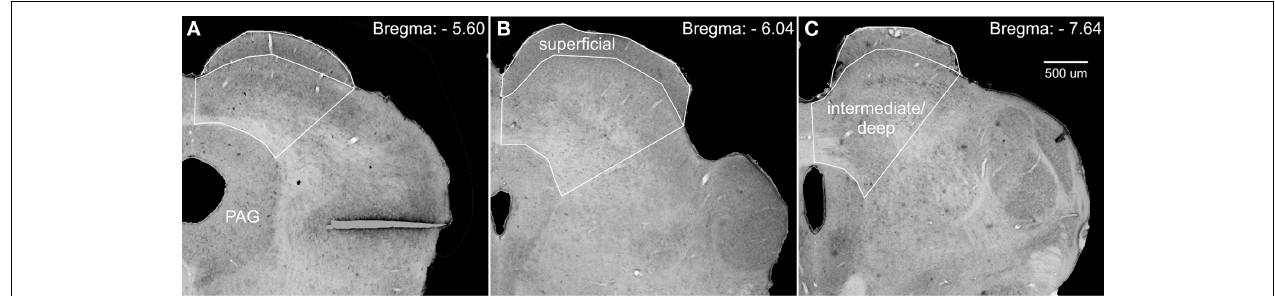
superior colliculus by a line extending from the lateral edge of the superficial layers to the lateral border of the periaqueductal gray (PAG). (A–C) Show increasingly more posterior sections and subsequently adjusted